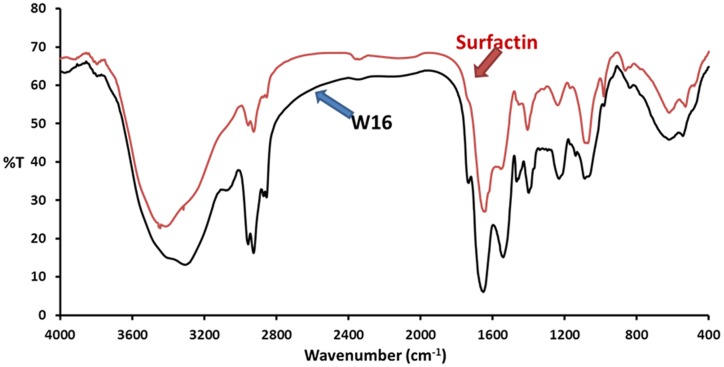
The FTIR absorption spectra of biosurfactant produced by B. licheniformis W16, and reference standard lipopeptide biosurfactant – surfactin (Sigma Chemicals, USA).